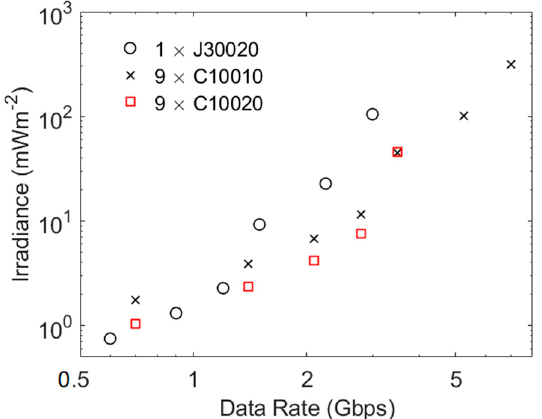
Figure 10. The potential performance of a J30020 and combinations of 9 C10010 SiPMs as well as 9 C10020 SiPMs. These results were obtained using the same methodology as used to obtained the results in Figure 9.